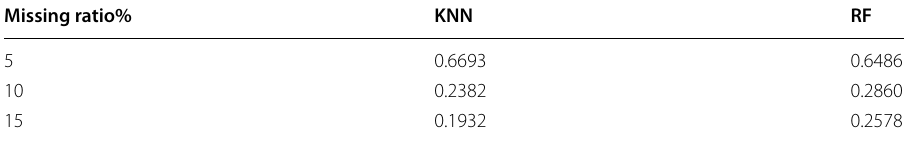
Table 4 RMSE of KNN and RF imputation at different ratios on the Iris dataset Missing ratio%